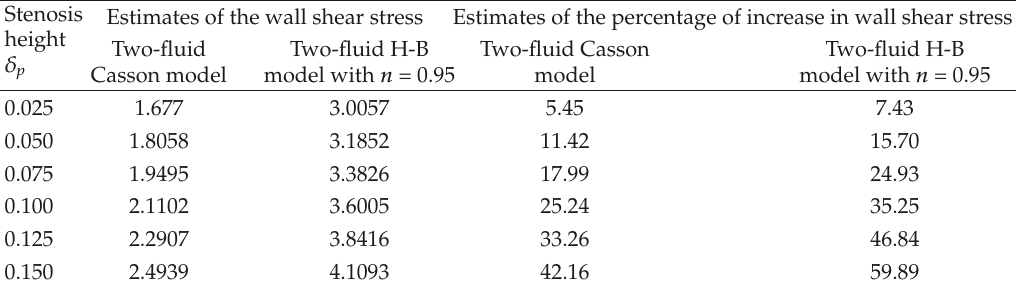
Table 1: Estimates of the wall shear stress (cid:2) τ w (cid:3) and percentage of increase in the wall shear stress (cid:2) τ w (cid:3) of the two-fluid Casson model and two-fluid Herschel-Bulkley model over uniform diameter tube for di ff erent stenosis sizes with A (cid:7) α (cid:7) α H (cid:7) 0 . 5 , β (cid:7) 0 . 985 , θ (cid:7) 0 . 1 , and t (cid:7) 45 ◦ . Stenosis Estimates of the wall shear stress Estimates of the percentage of increase in wall shear stress height Two-fluid Two-fluid H-B Two-fluid Casson Two-fluid H-B δ p Casson model model with n (cid:7) 0.95 model model with n (cid:7)